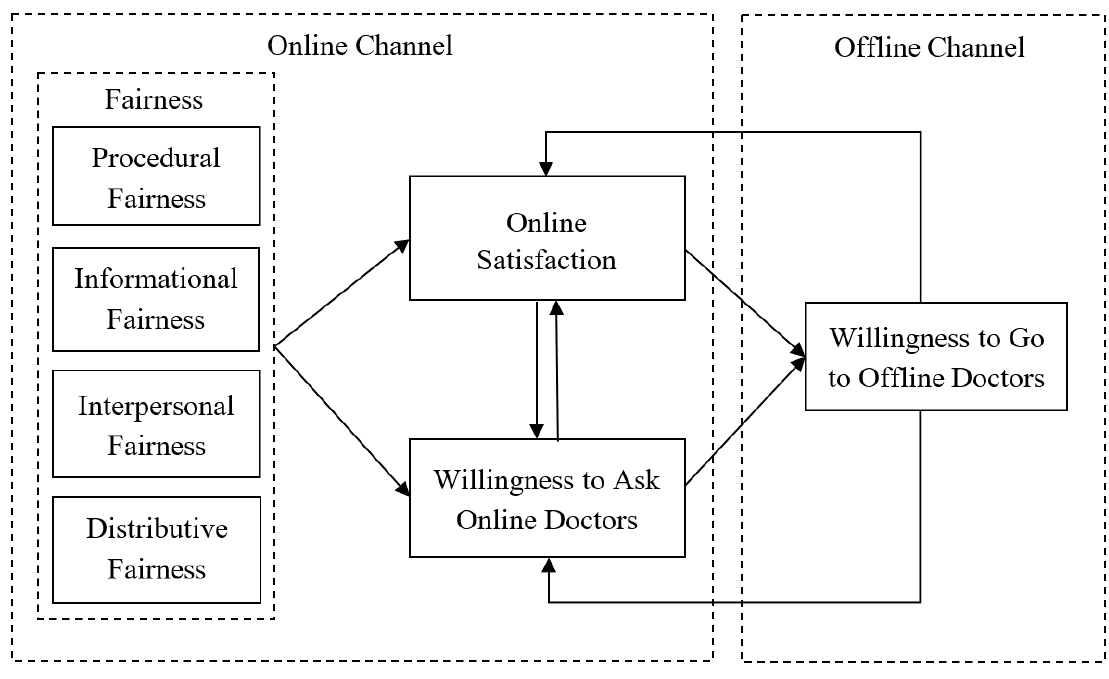
Figure 1. Conceptual model for sustainable eHealth.